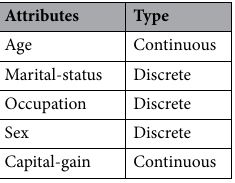
Table 3. Adult attributes and attribute types.